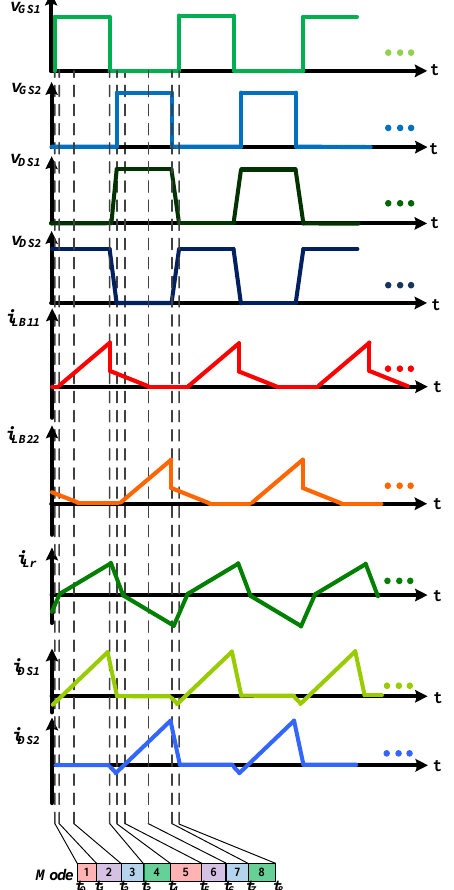
Figure 6. Key waveforms of the presented LED driver for streetlight applications.